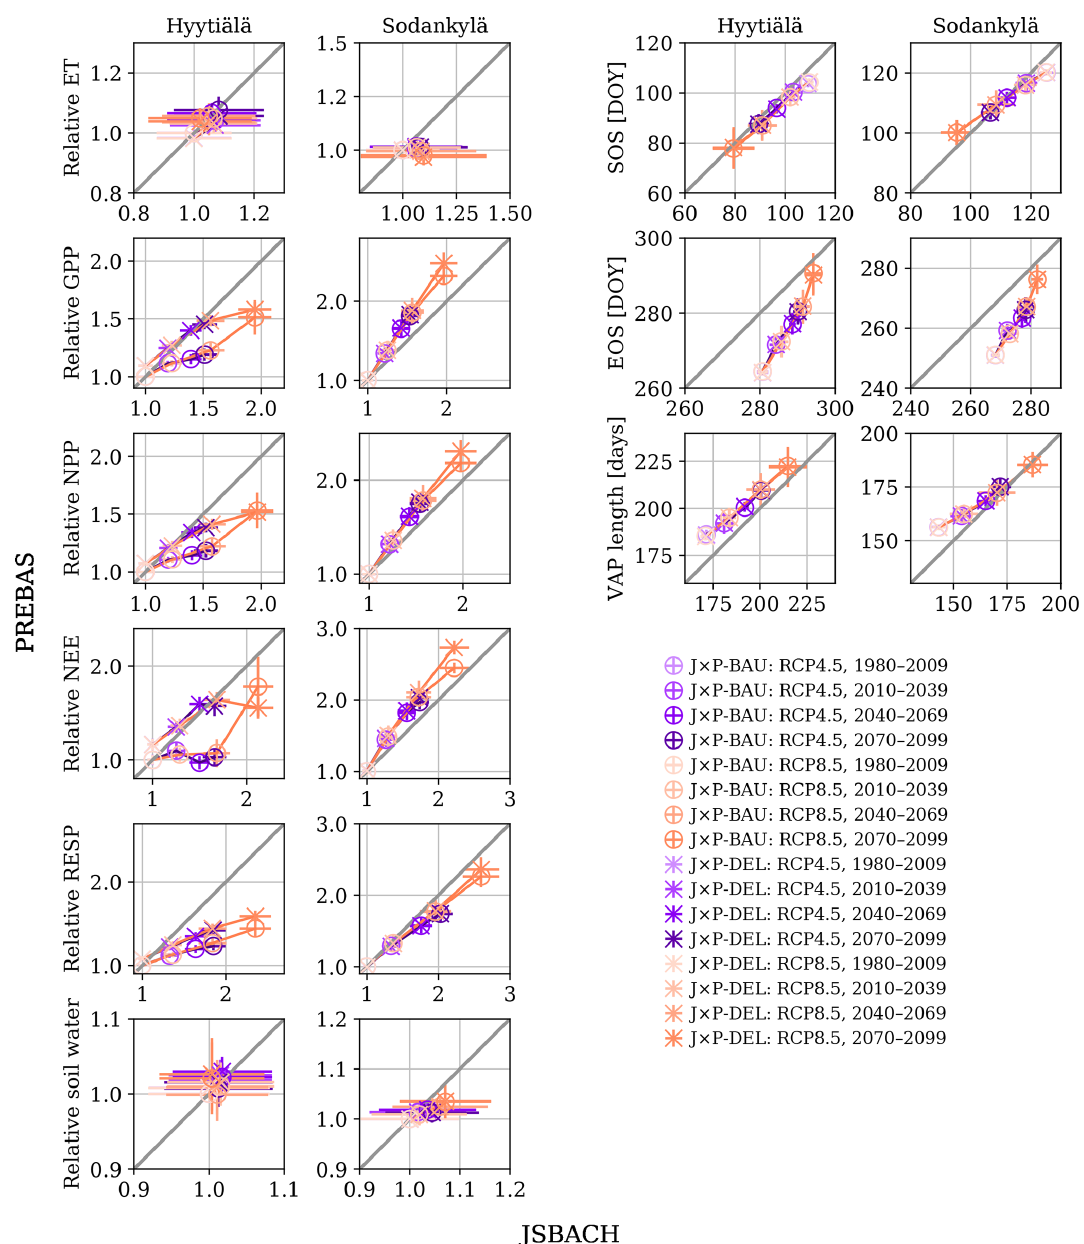
Figure 9. Average simulated values for shared ecosystem indicators between JSBACH and PREBAS, plotted for each 30-year period and both RCP4.5 and RCP8.5 scenarios. The values for JSBACH are divided by the average of the reference period values, and the values for PREBAS are divided by the average of the BAU scenario reference period values. The whiskers at each point represent the point-specific uncertainty: 1 standard deviation amongst the corresponding simulations. We use lighter shading for the earlier